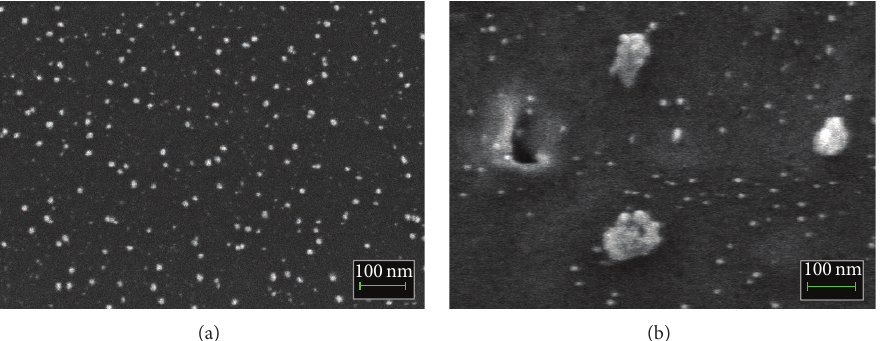
Figure 4: FESEM image of PANI-Ag 0.2 -Fe 0.8 nanocomposite thin film (a) before annealing and (b) after